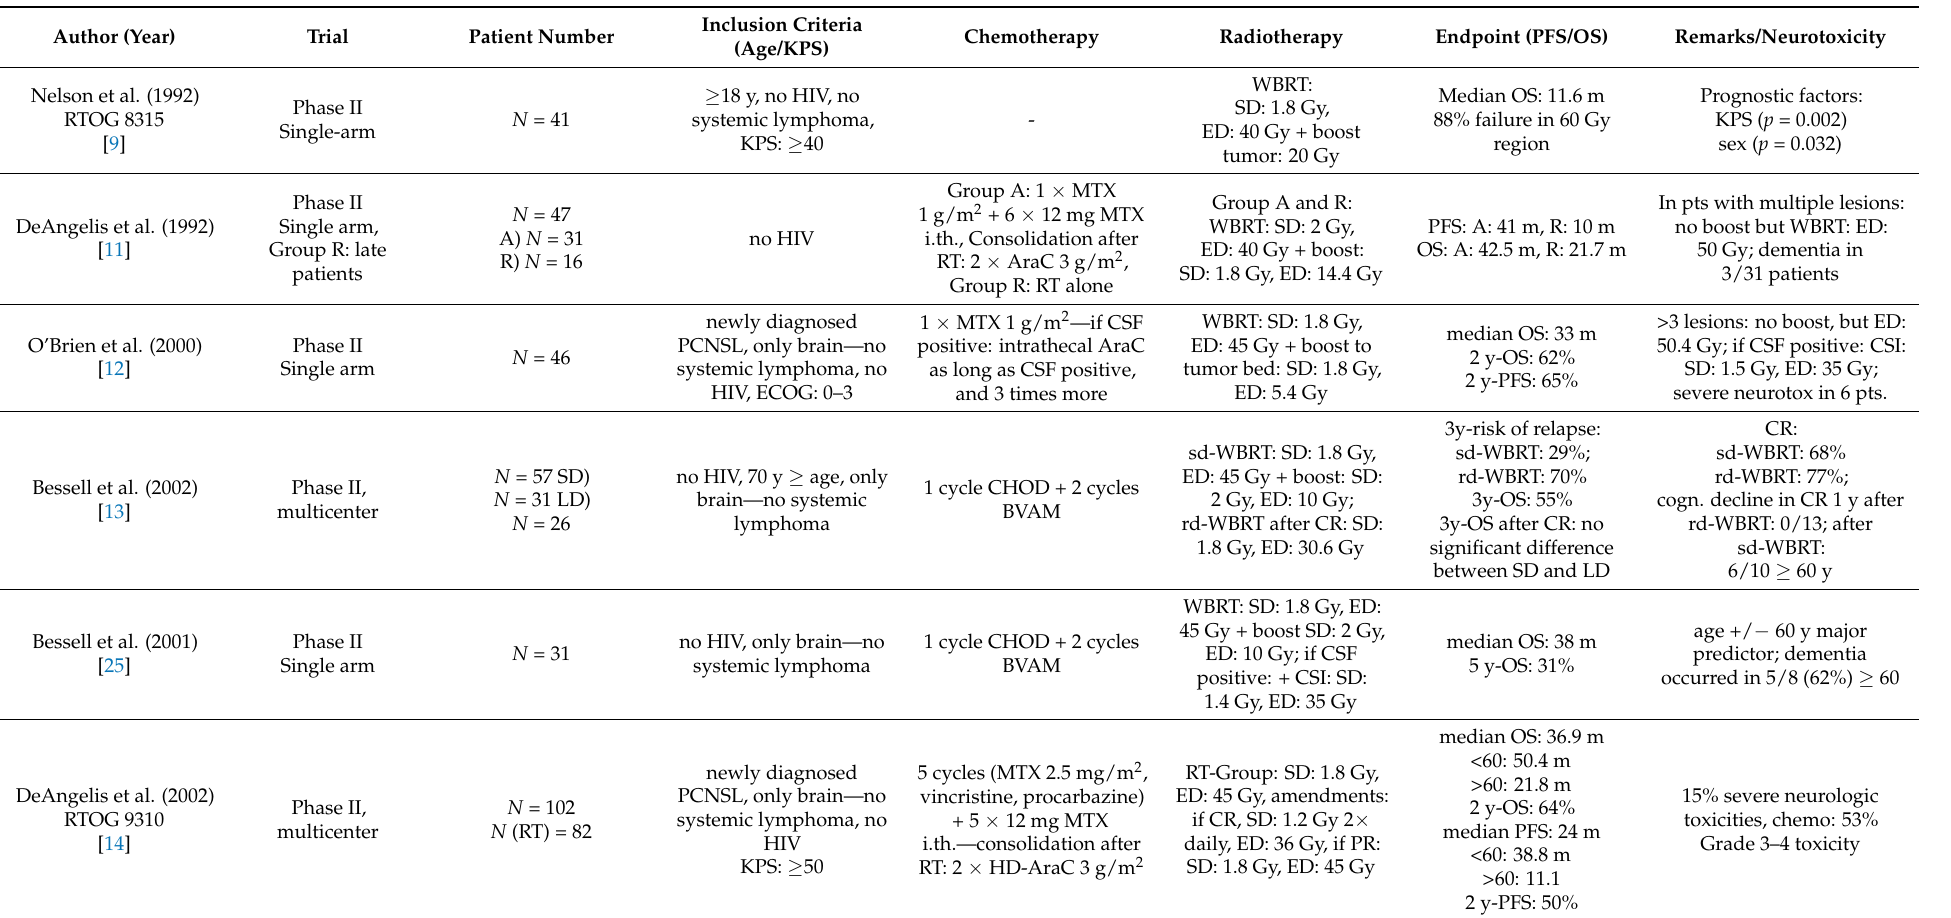
Table 1. Clinical